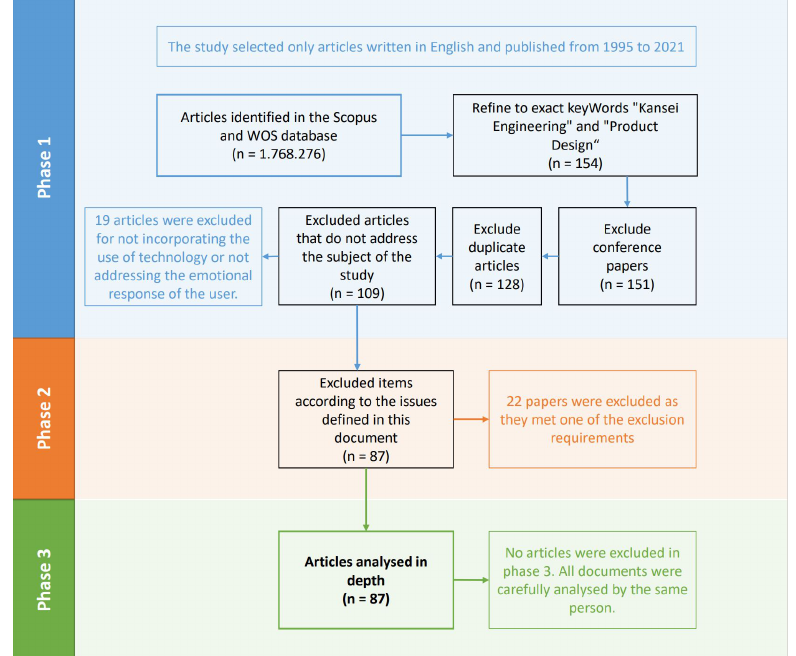
Figure 2. SLR process flow